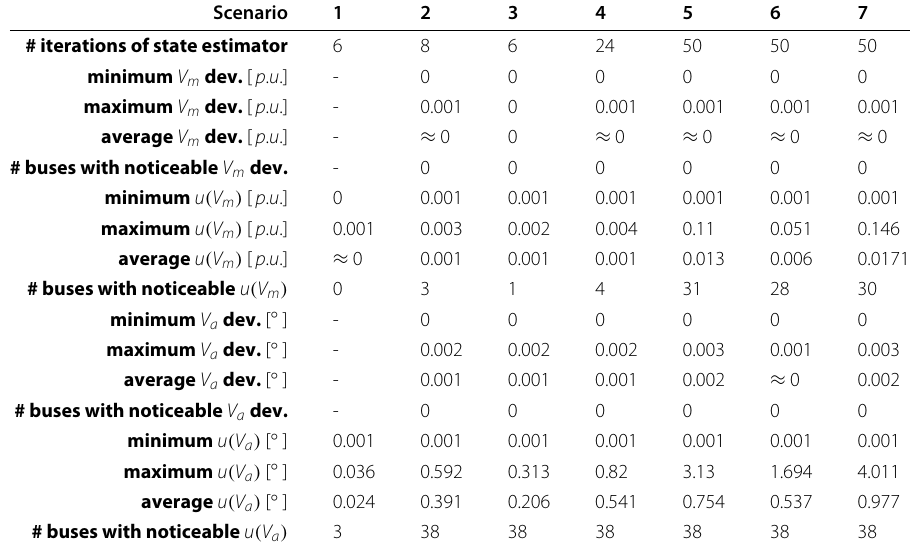
Table 1 Overview of the results for the respective scenarios compared to the baseline Scenario 1 Scenario 1